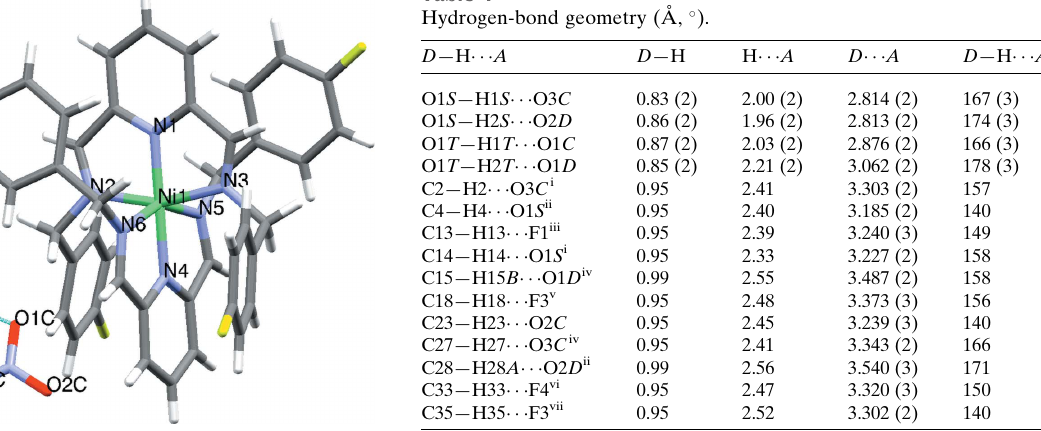
Figure 1 Asymmetric unit of the title compound showing the atom-numbering scheme. Displacement ellipsoids are drawn at the 50% probability level; O—H (cid:2)(cid:2)(cid:2) O hydrogen bonds are shown as light-blue